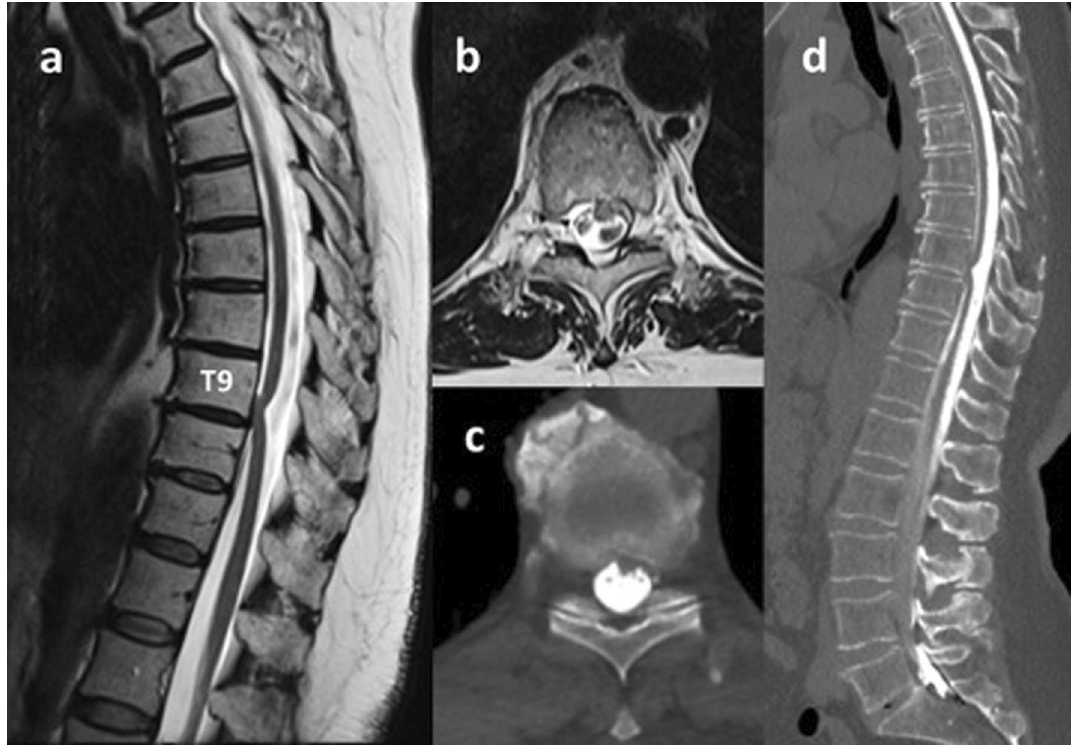
Fig. 1 Preoperative MRI and CT-myelogram. A T2-weighted sequence sagittal MRI showing the herniated spinal cord ventrally. B T2-weighted sequence axial MRI showing the central herniation of the spinal cord through the ventral wall of the dura mater. C CT-myelogram confirms that there is no accompanying arachnoid cyst. D Sagittal CT-myelogram imaging of the spinal